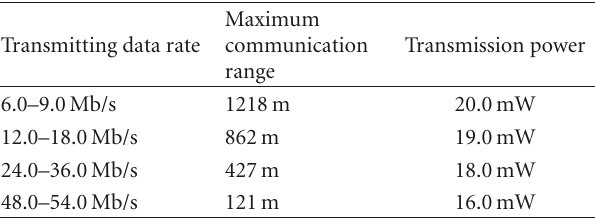
Table 2: Maximum communication range and transmission power for transmitting data rate.